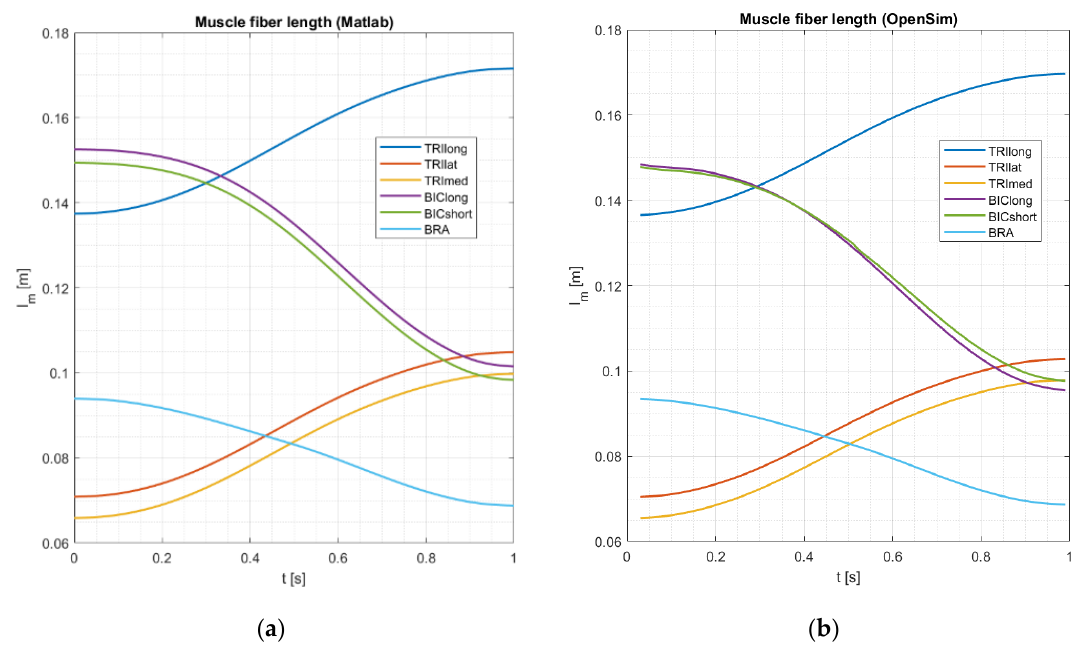
Figure 12. Muscles’ fiber lengths comparison: ( a ) Matlab ( a ) and ( b ) OpenSim.